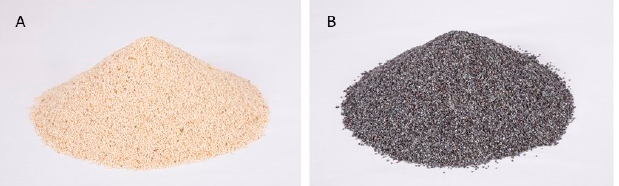
Figure 3. Color of opium poppy seeds may vary from white-yellowish to dark blue. An example is shown for white seeds ( A ) from cultivar ‘Weiss’ and for grey seeds ( B ) from cultivar ‘Minoan’ (Photo: Zámboriné Németh, É.).